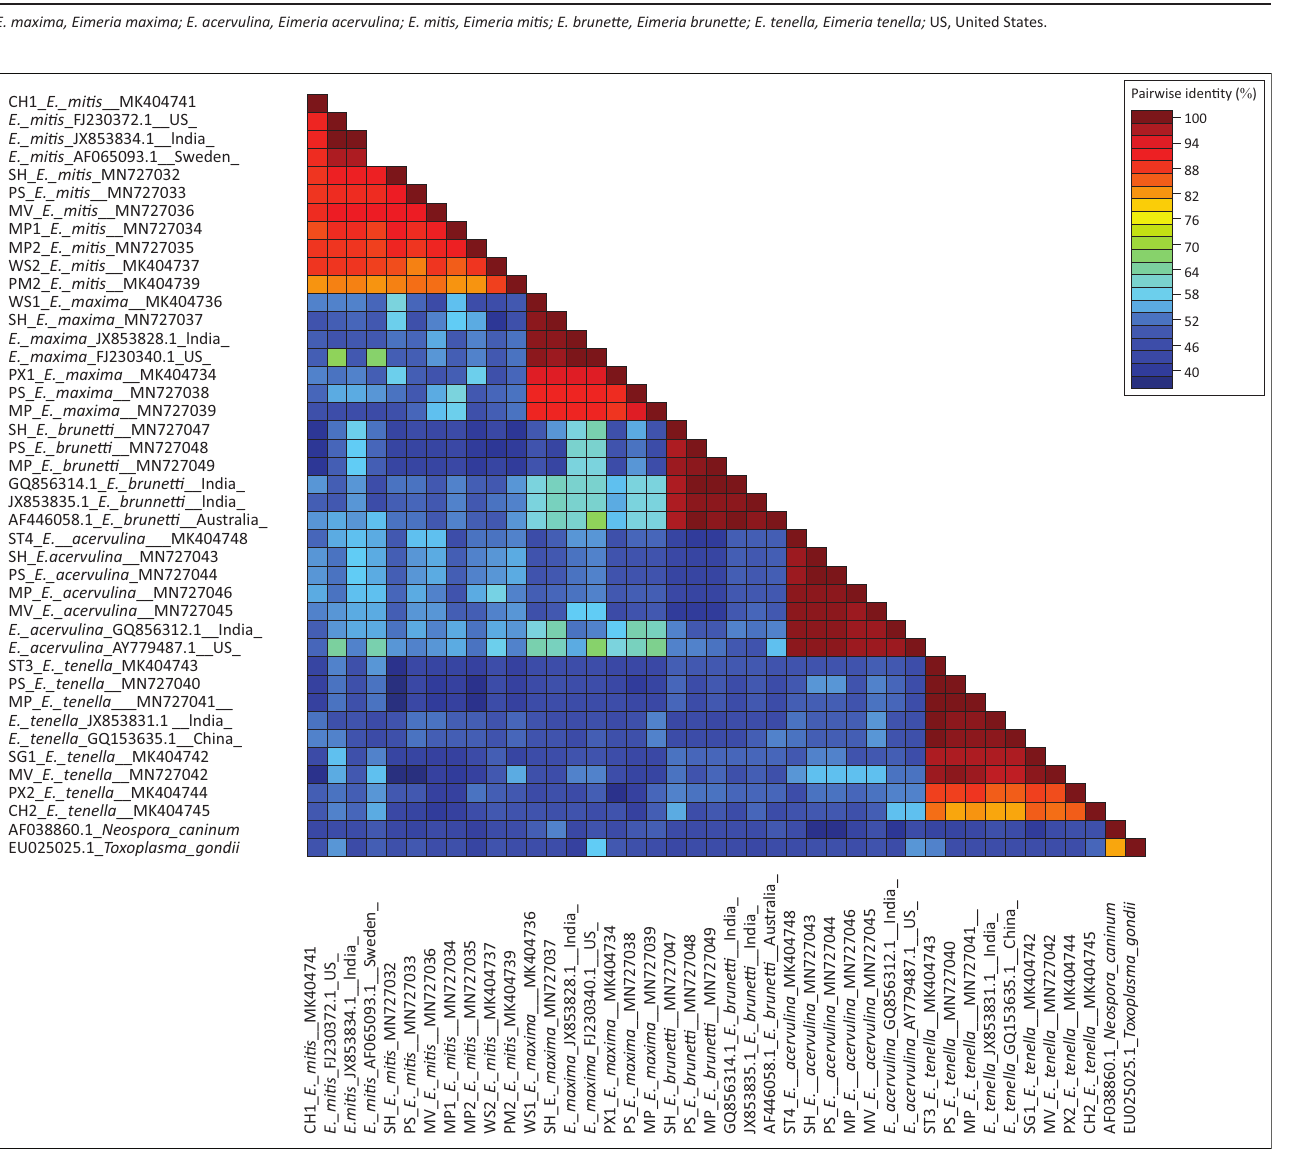
FIGURE 1–A1: Pairwise percentage identity of ITS-1 sequences of different Eimeria